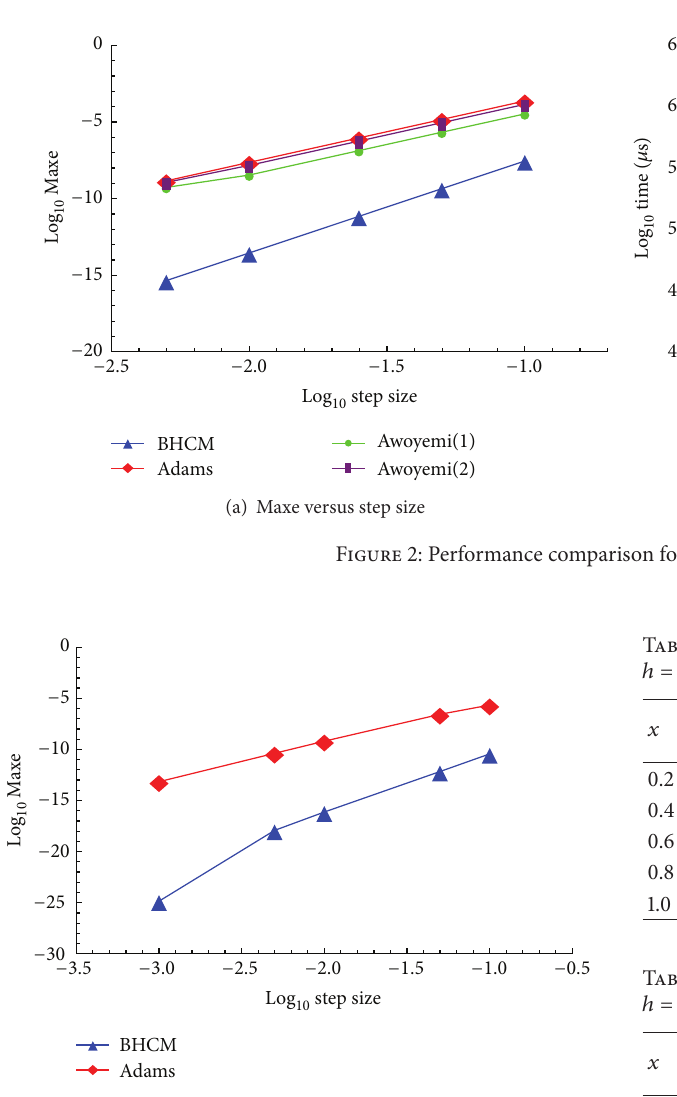
Figure 3: Performance comparison for Problem 3 when 𝑏 = 1 .